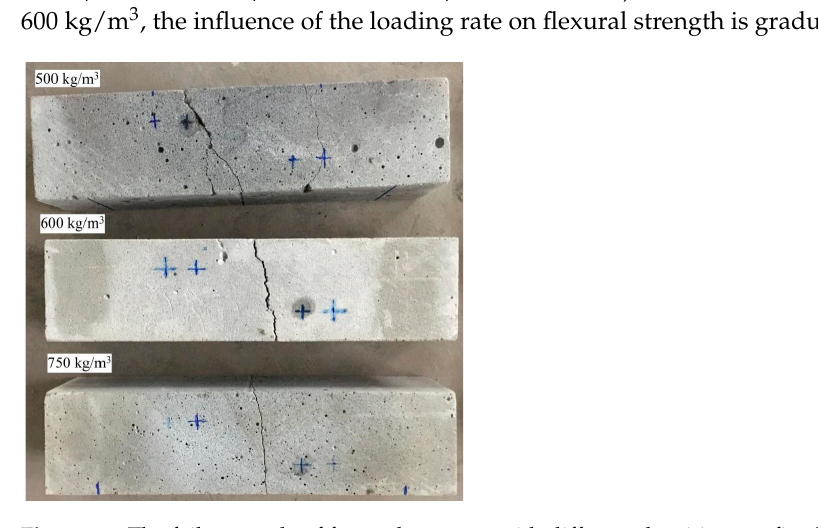
12 of 26 Figure 13. Relationship between flexural strength and density of foam concrete under different load- ing rates. Figure 14 shows the failure mode of foamed concrete with different densities at a fixed loading rate. In Figure 14, when the density is high, the failure section is relatively flat, approximately in a straight line; when the density is low, the failure section is rela- tively rough, and the failure angle is large. This phenomenon is consistent with the flex- ural failure of light-weight foam concrete with expanded clay aggregates carried out by Lu et al. [41]. This is mainly due to the distribution of more pores inside the foamed con-